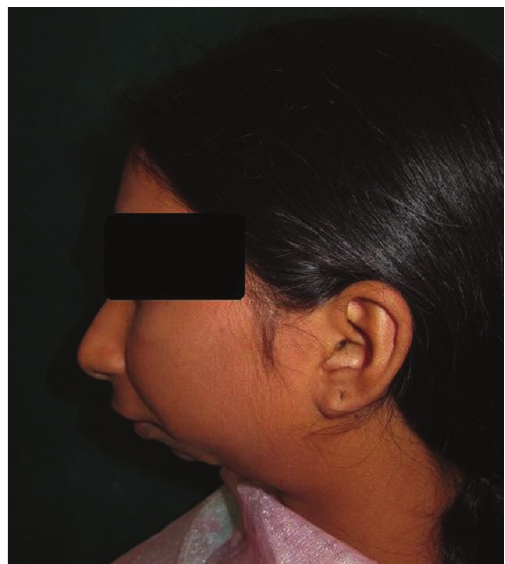
Figure 2: Lateral view of patient shows severe retruded mandible.